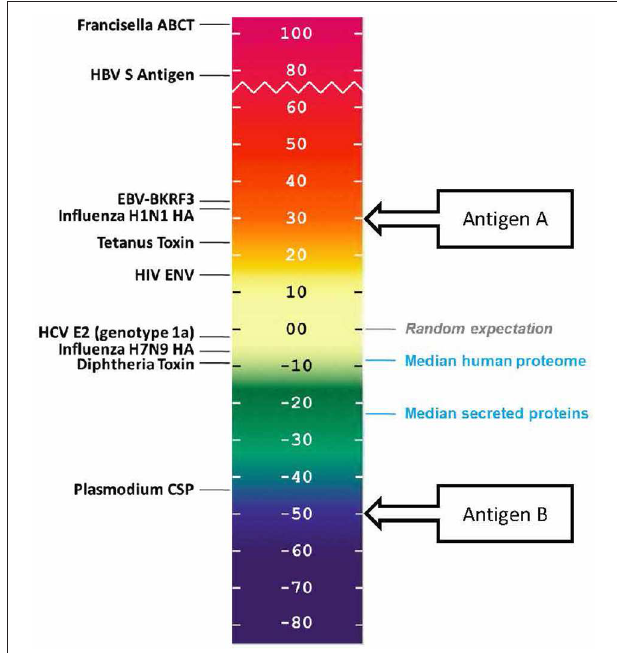
FIGURE 4 | EpiMatrix immunogenicity scale, showing vaccine antigens, human proteins that have been reported to be immunogenic, and non-immunogenic antigens alongside the median scores for sets of proteins from the human genome. The vaccine antigen sequences were obtained from UniProt. The EpiMatrix immunogenicity scale is set to zero based on the median HLA DR score of a set of random protein sequences. Normalization of the HLA scoring enables direct comparison of median HLA DR scores to candidate antigens; for example, candidate vaccine antigen A would be preferred over candidate vaccine antigen B for inclusion in a vaccine designed to elicit T helper immune response and to drive humoral